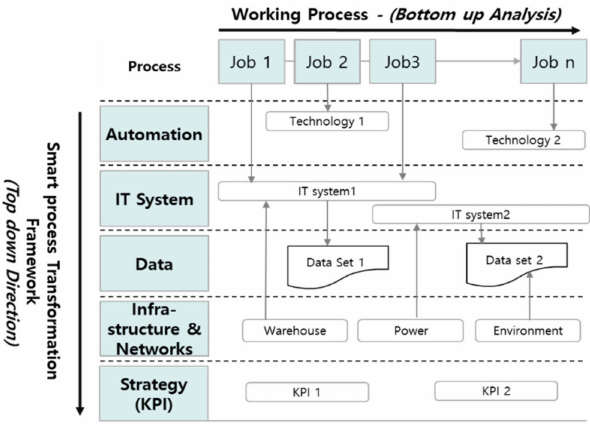
Figure 5. Template for analysis of on-site